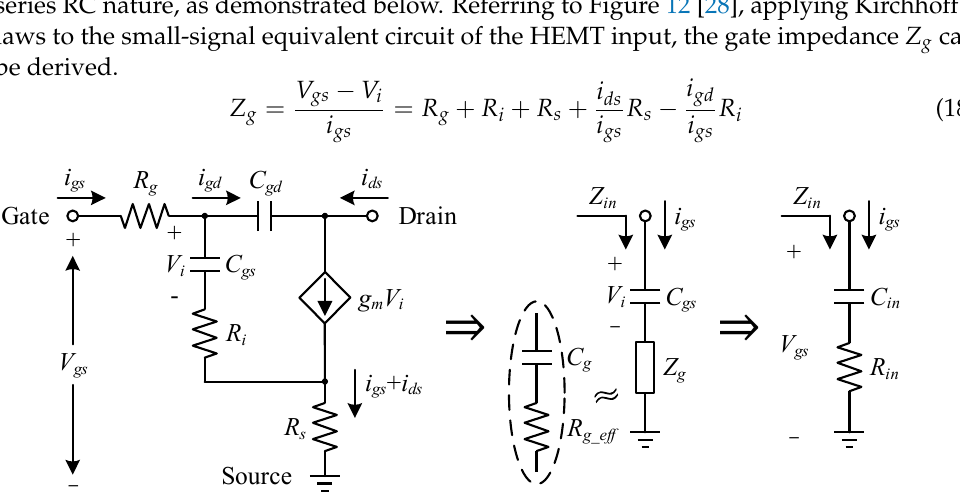
Figure 12. Equivalent circuit for the input of an HEMT in the common-source configuration and its simplified series RC model.